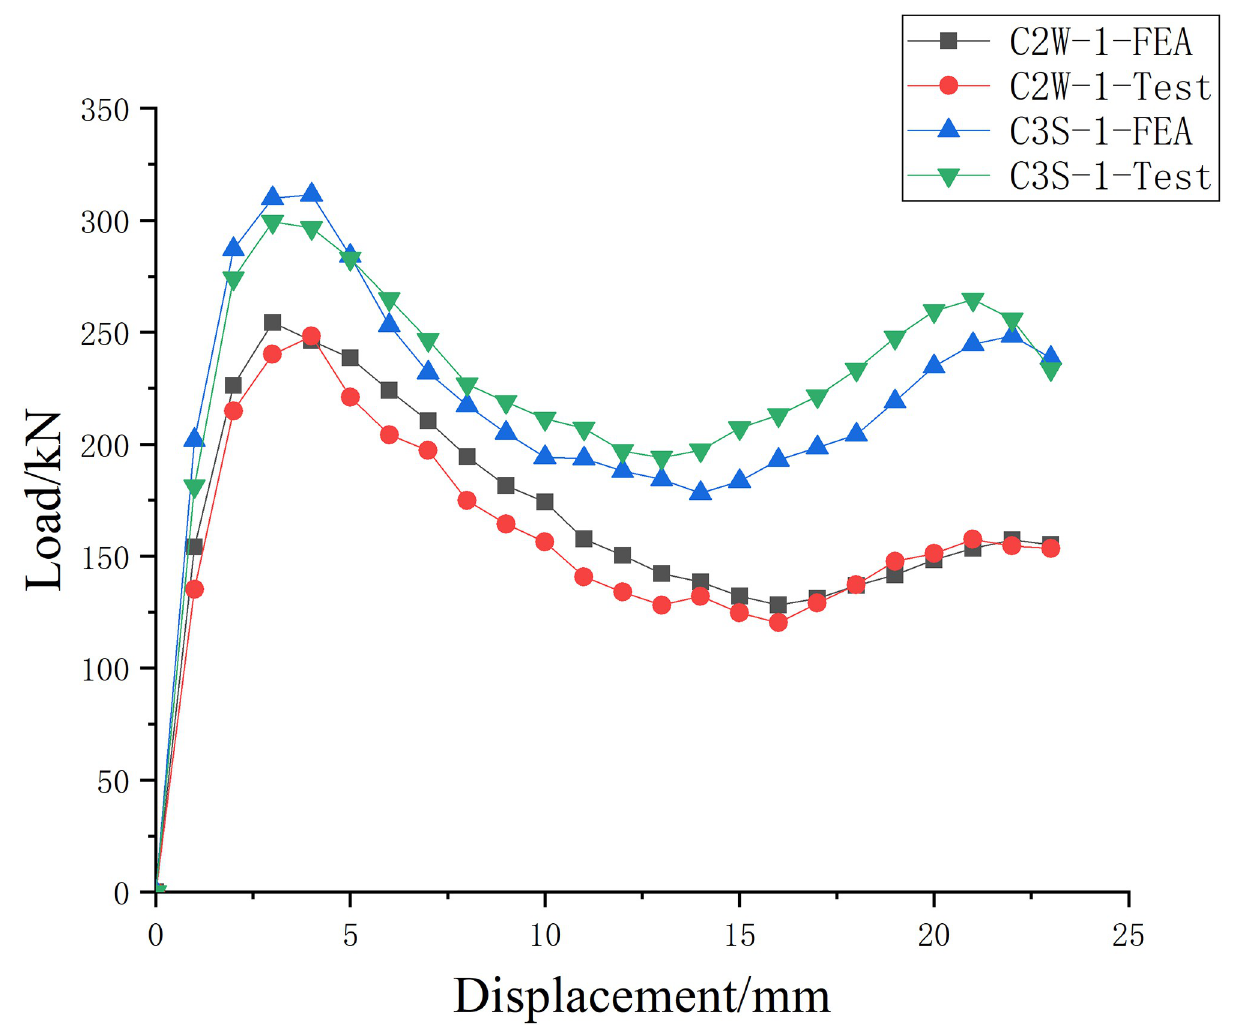
Fig 16. Load displacement